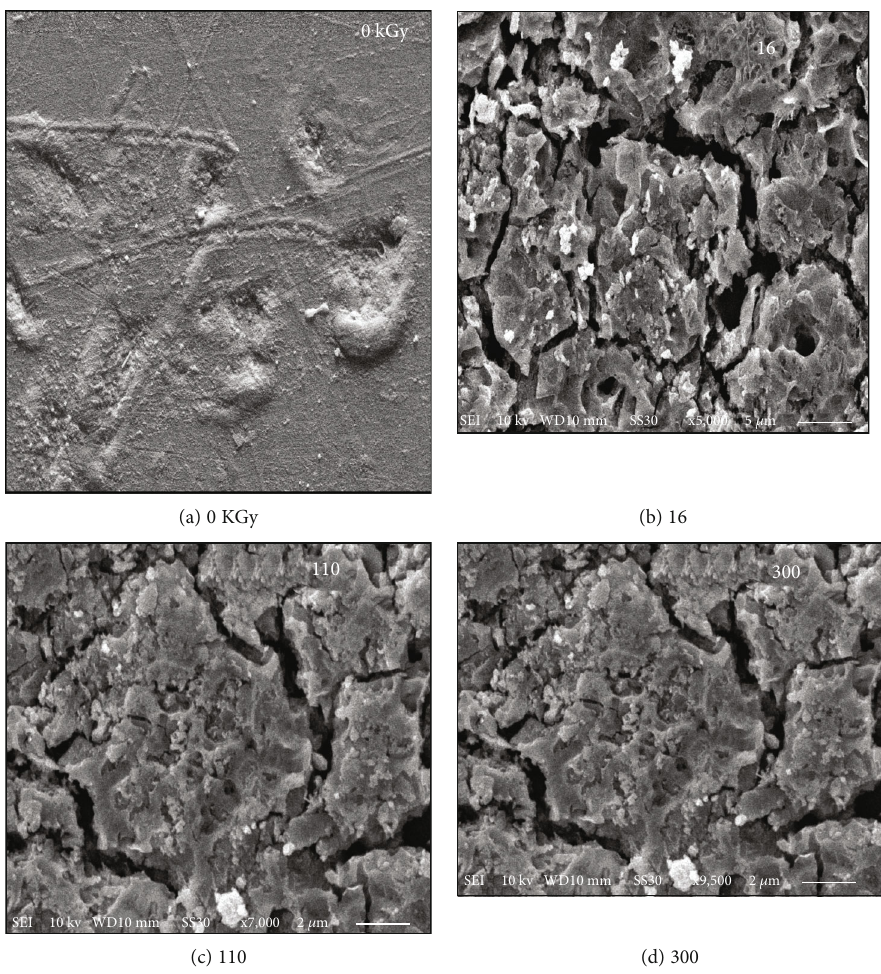
Figure 7: SEM Micrographs of UHMWPE. (a) Pristine. (b) 16 kGy. (c) 110kGy. (d)